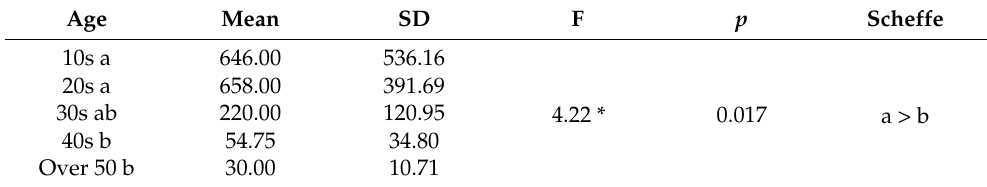
Table 7. Digital Sex Crimes by Age for Women.